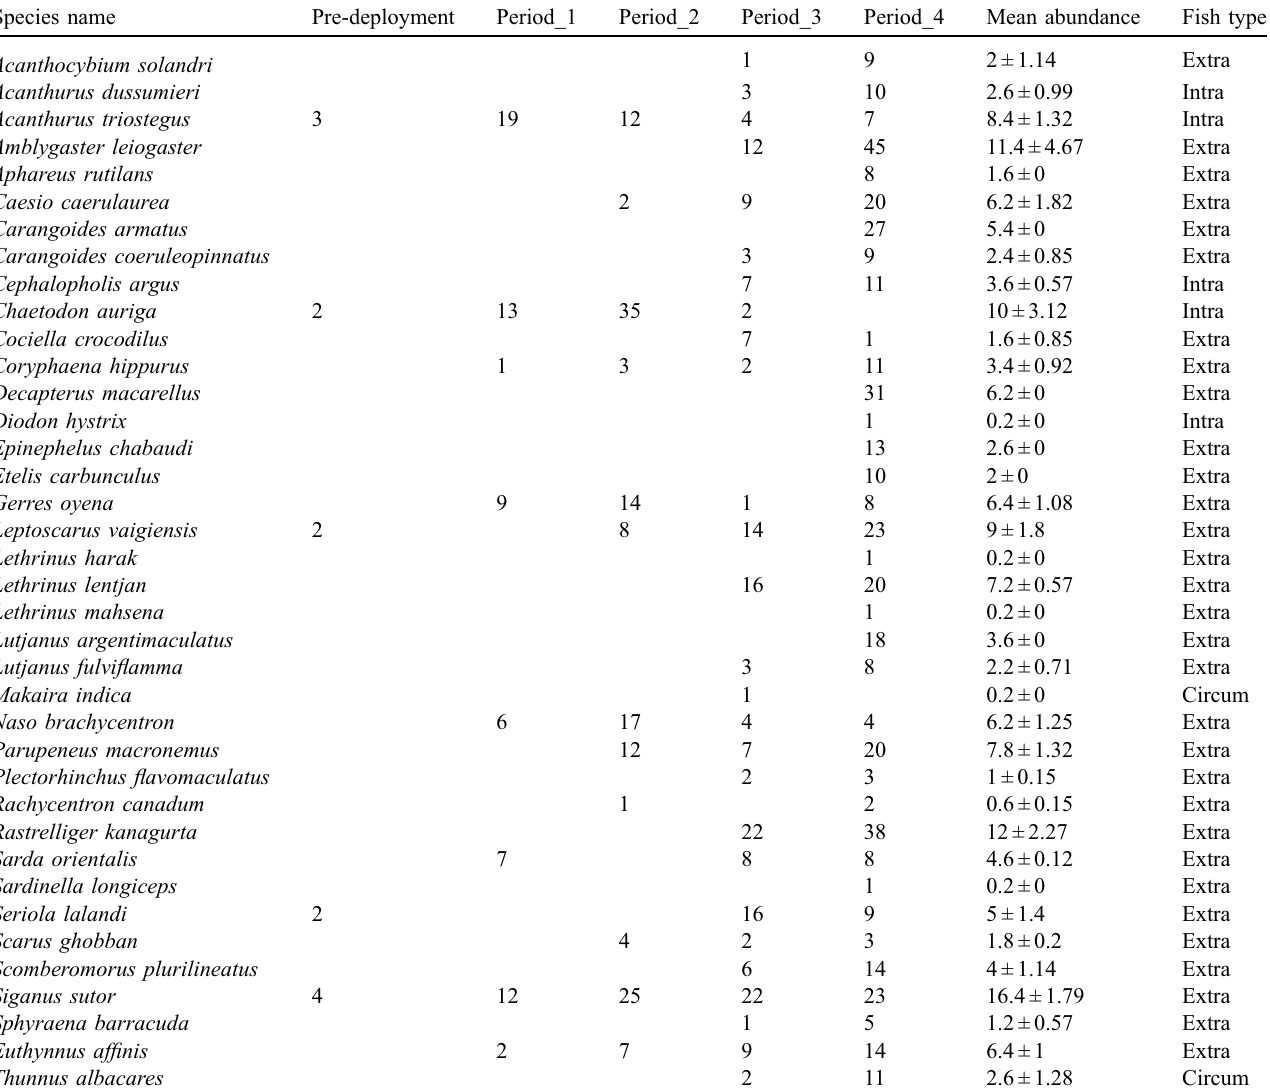
Table 2. Seasonal occurrence of the species beneath FADs observed through underwater visual census in coastal Kenya. Pre-deployment April 2014, Period_1 (cid:2) April 2014; Period_2 (cid:2) June 2014; Period _3 (cid:2) November 2014; Period_4 (cid:2) February 2015. Mean abundance is number of individuals per FAD± SD. Intra (cid:2) intranatant, Extra (cid:2) extranatant, Circum (cid:2) circumnatant